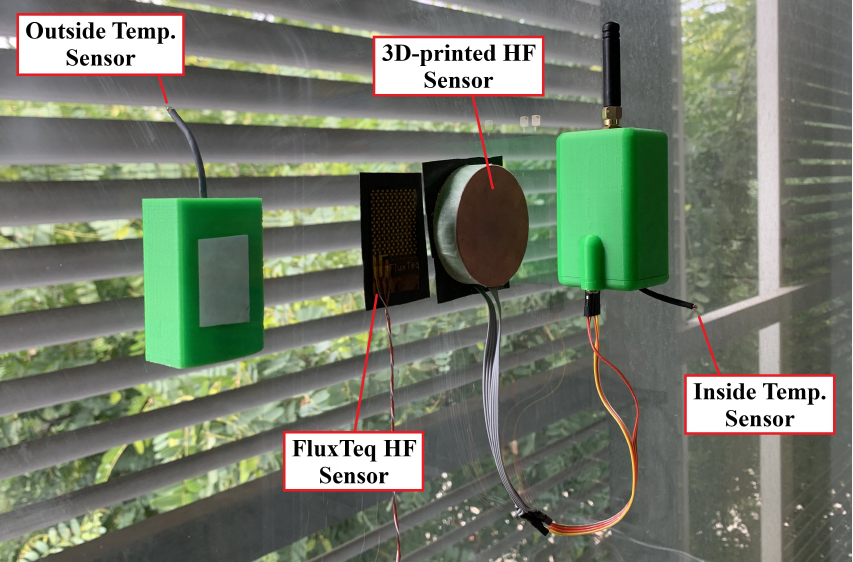
Figure 15. Photograph of the measurement nodes installed in a large double-glazed insulating glass. The main node has been installed inside and the outdoor temperature sensor has been attached outside, avoiding direct exposure to